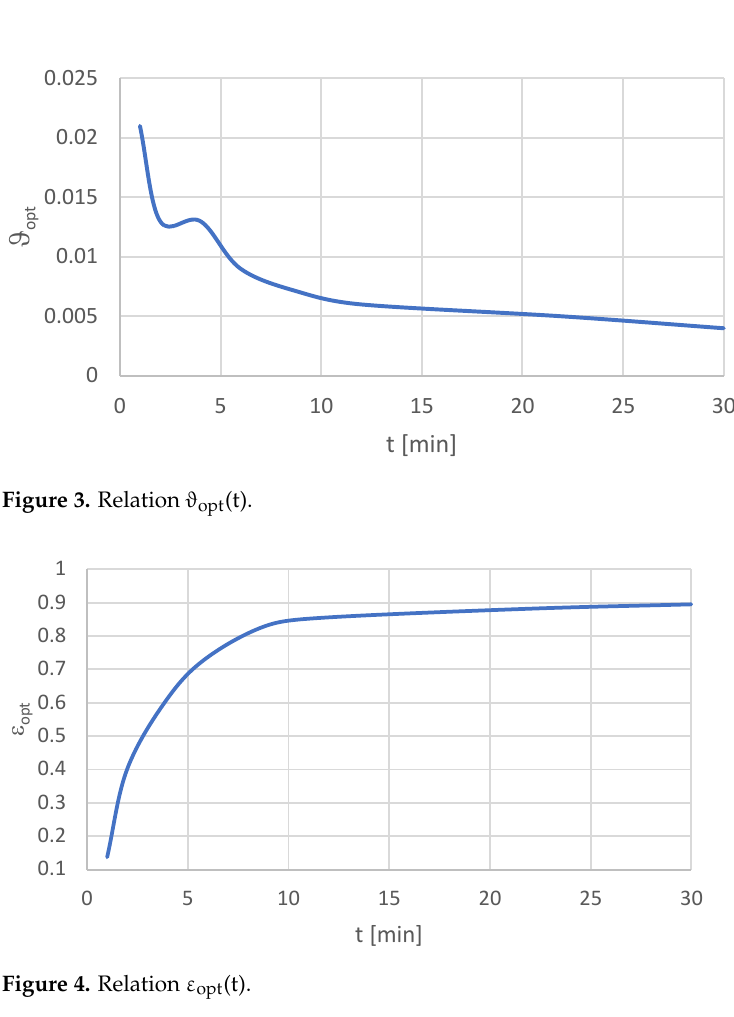
Figure 2. Relation β opt (t).